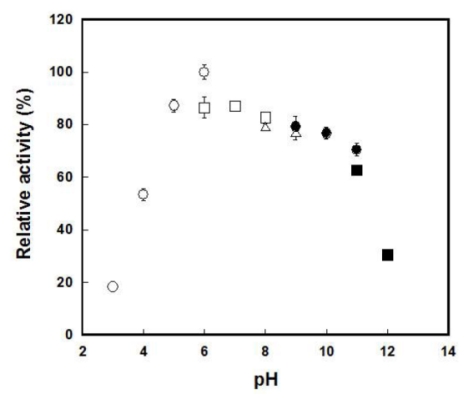
Effect of pH on activity of PktA. The buffers (50 mM) used were as follows: pHs 3.0–6.0, sodium citrate (open circles); pHs 6.0–8.0, sodium phosphate (open squares); pHs 8.0–9.0, Tri-HCl (open triangles); pHs 9.0–11.0, Na2HCO3-NaOH (closed circles); pHs 11.0–12.0, NaHPO4-NaOH (closed squares).